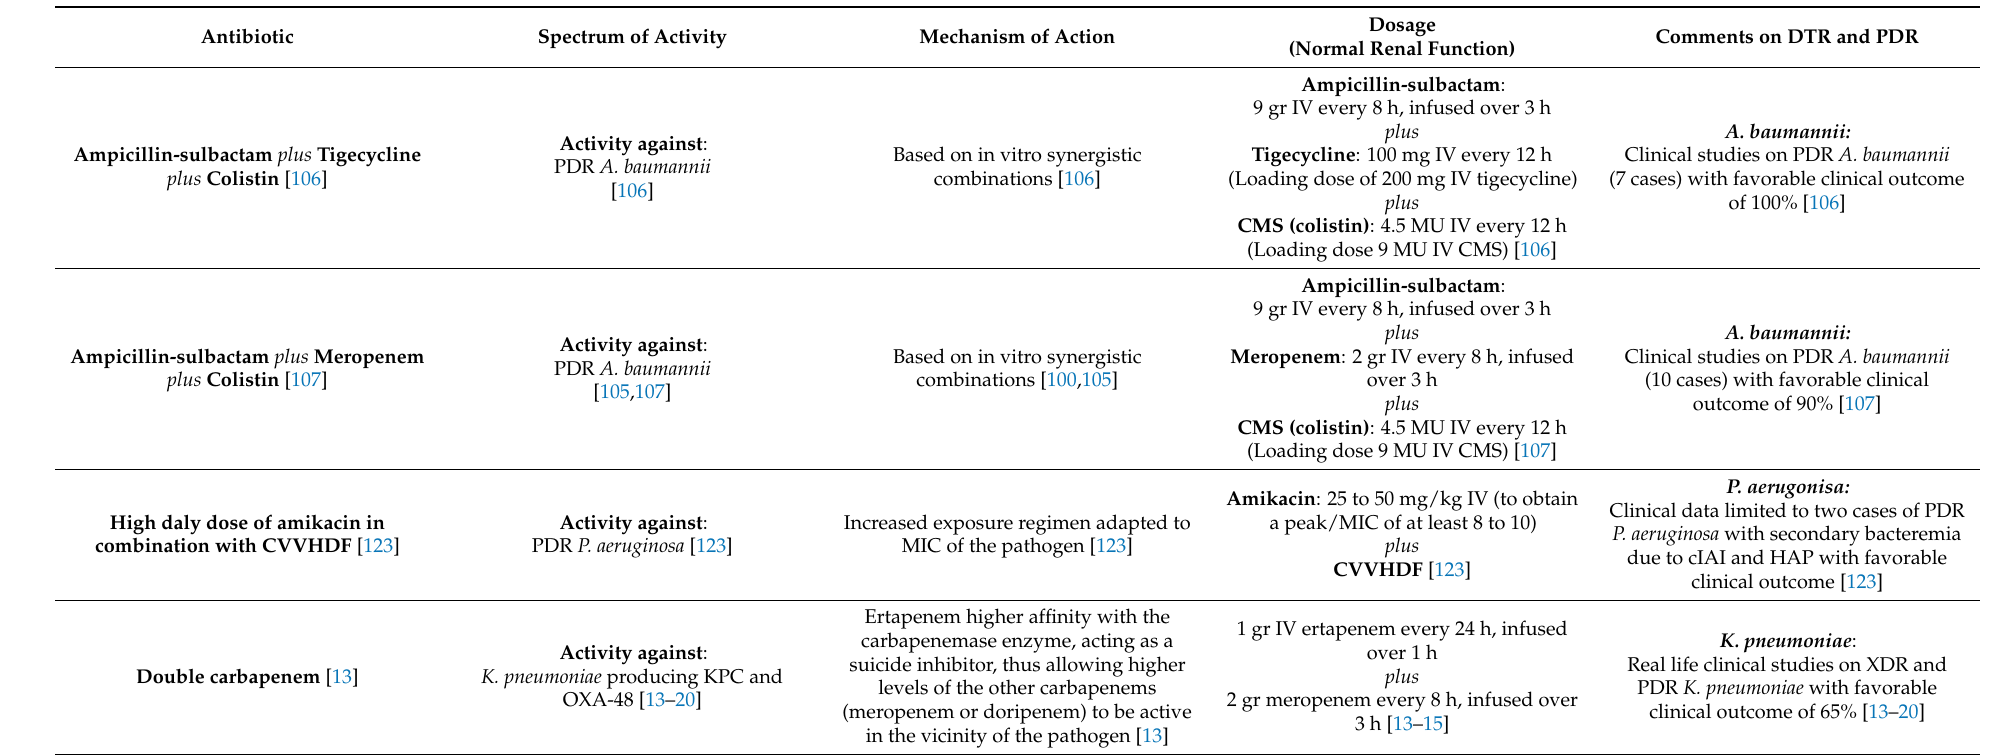
Table 2. Salvage therapeutic options for DTR and PDR Gram-negative